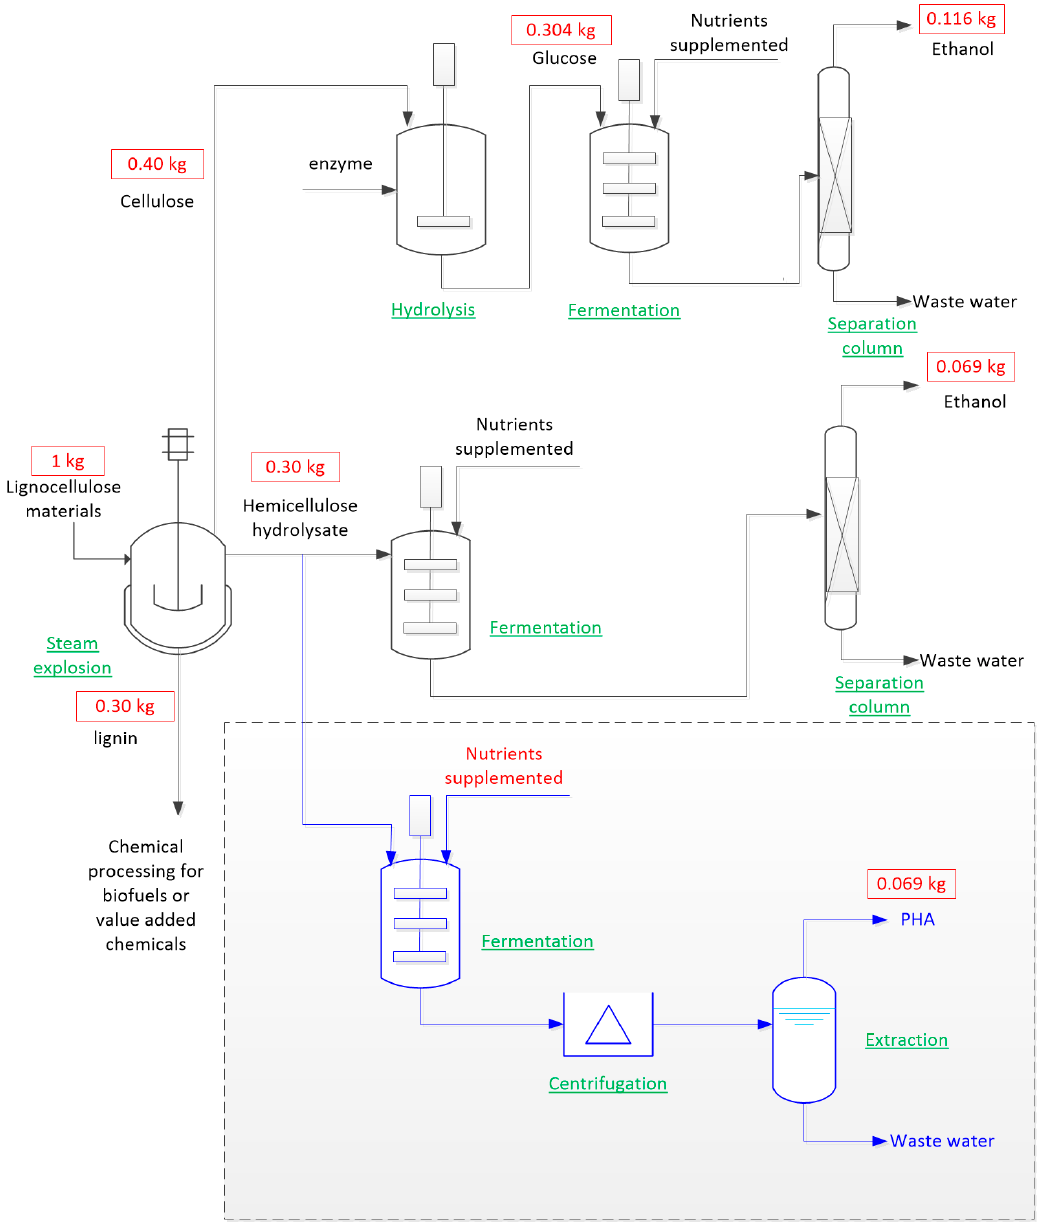
Figure 7. A schematic diagram and mass balance (red) of the proposed integrated biorefinery for producing bioethanol (black) and biopolymer (blue) by various process stages (green). The part in the dashed line box is the proposed production of PHAs using the hemicellulose hydrolysate stream. Cellulose to glucose conversion and recovery efficiency is 0.76 g/g, and fermentation of glucose to ethanol is 0.38 g/g [114]. Hemicellulose to xylose conversion and recovery efficiency is 0.90 g/g, and fermentation of xylose to ethanol is 0.26 g/g [114]. Fermentation of xylose to PHA is 0.26 g/g [48], and fermentation of hemicellulose hydrolysate is 0.90 × 0.26 = 0.23 g/g, where 0.90 is the hemicellulose to xylose conversion and recovery efficiency, which is the same as the hemicellulose hydrolysate used to produce ethanol.